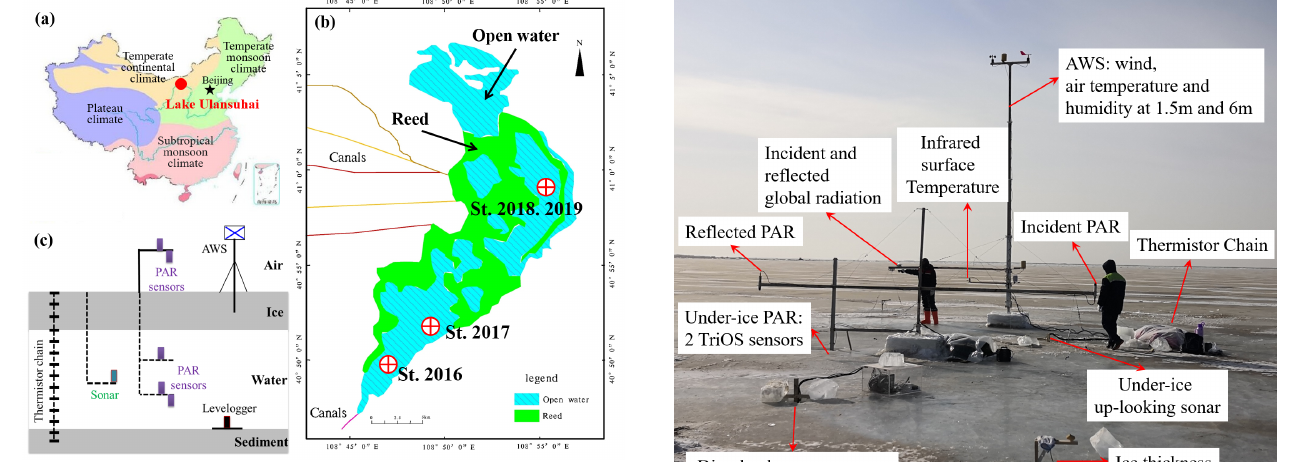
Figure 1. Locations of Lake Ulansuhai (a) and study sites (b) and the field instrumentation (c) . In each winter, a thermistor chain was refrozen into the ice cover to measure the temperature profile of the air–ice–water–sediment column with an established automatic weather station (AWS); more than three radiation sensors over the photosynthesis active radiation (PAR) band were deployed to ob- serve the incident, reflected, and transmitted solar radiation.